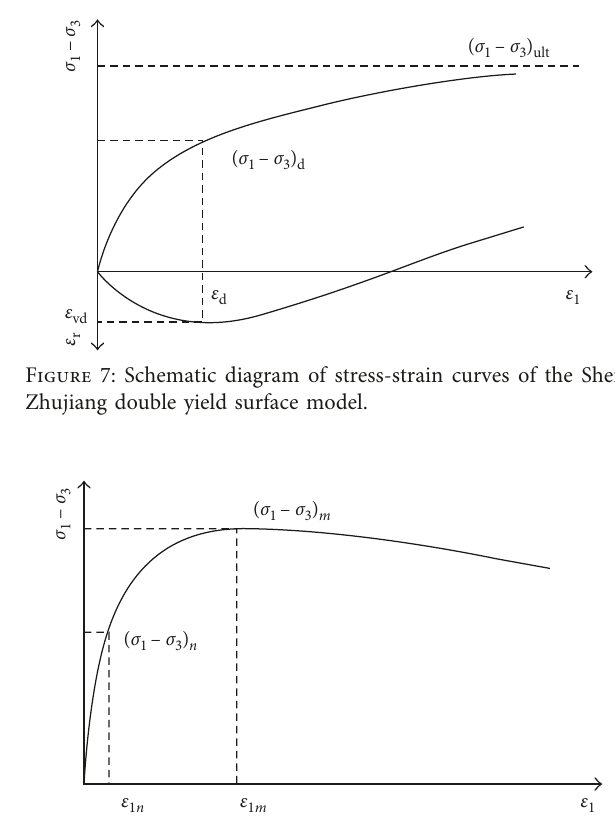
Figure 8: Schematic diagram of physical meaning of some